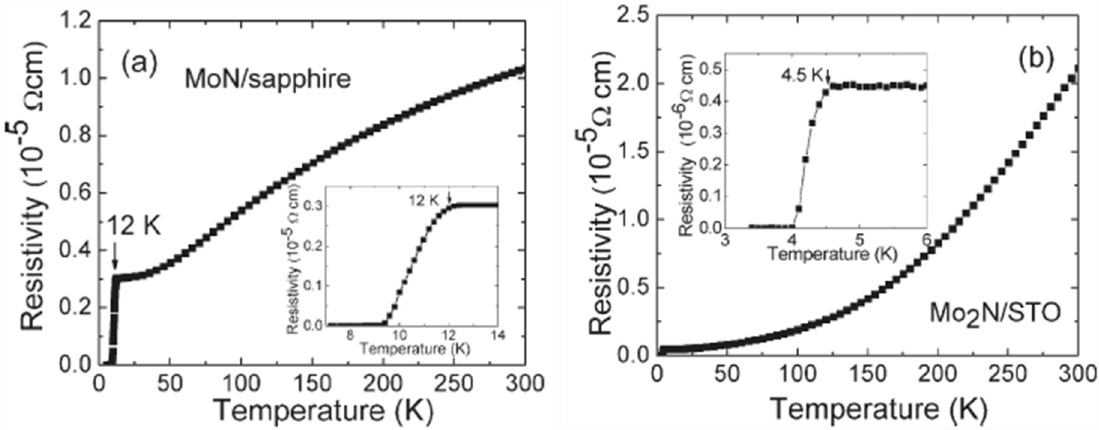
Figure 5. ( a ) Temperature dependence of resistivity of hexagonal MoN on Al 2 O 3 ; and ( b ) temperature dependence of resistivity of hexagonal MoN on STO. The inset is the plot of resistivity at low temperature [56]. Copyright ACS Publications